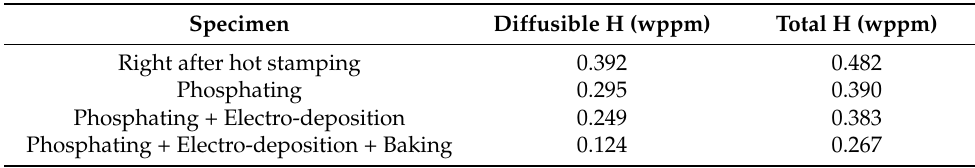
Table 7. Diffusible hydrogen and total hydrogen from TDS results after sequential process.